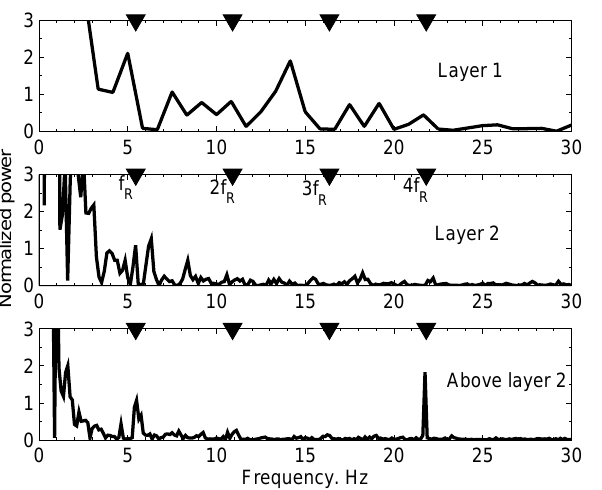
Fig. 7. The dust charge number density and the secondary current as a function of height in layer 1